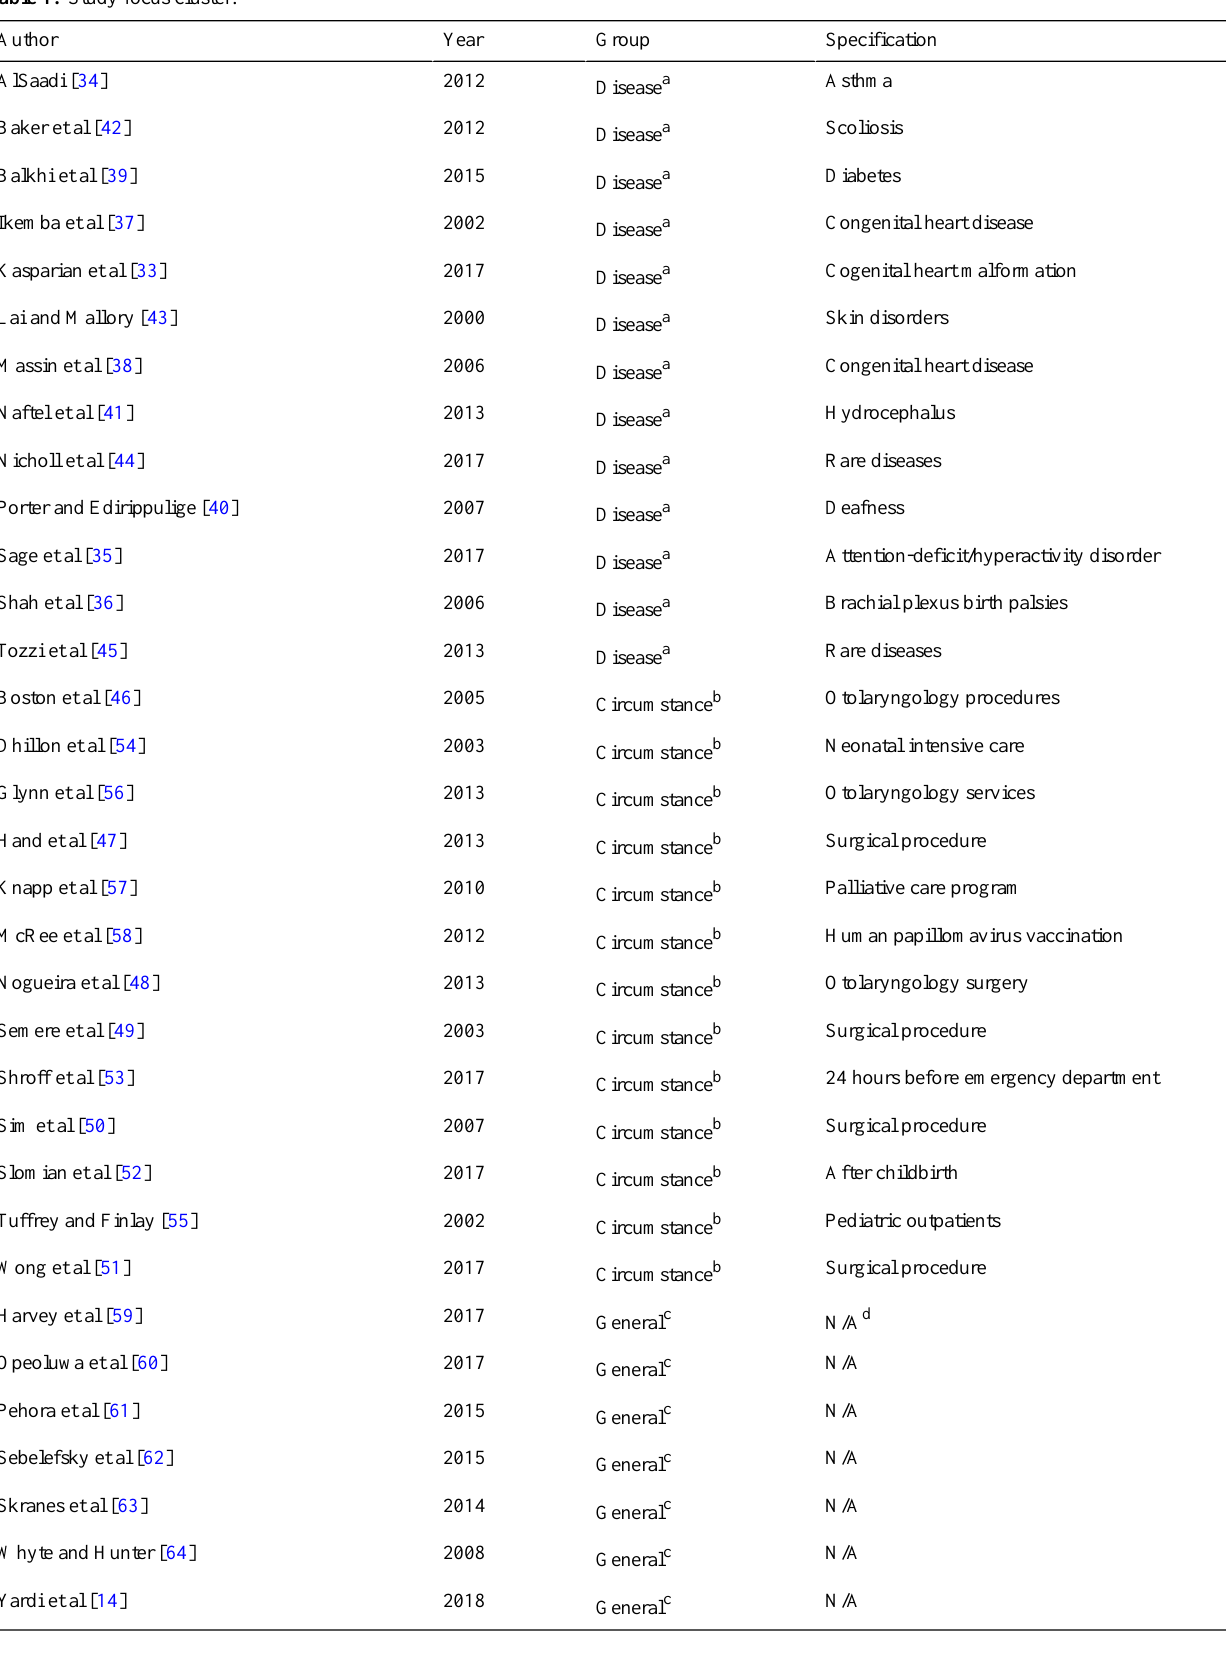
Table 1. Study focus cluster.